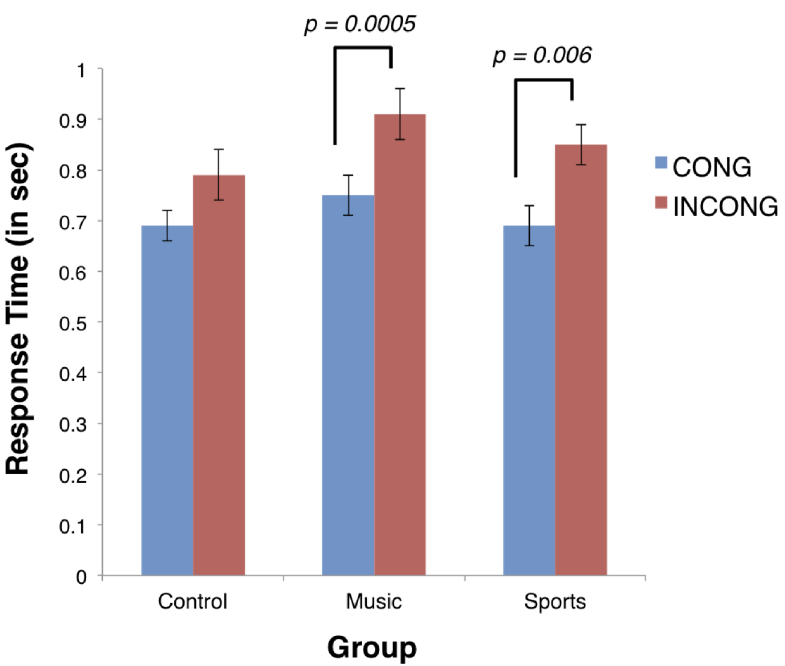
Fig 3. Response times inside the scanner during fMRI Color-Word Stroop task for each condition by group. Responsetime is measuredin seconds. Error bars represent standarderror.